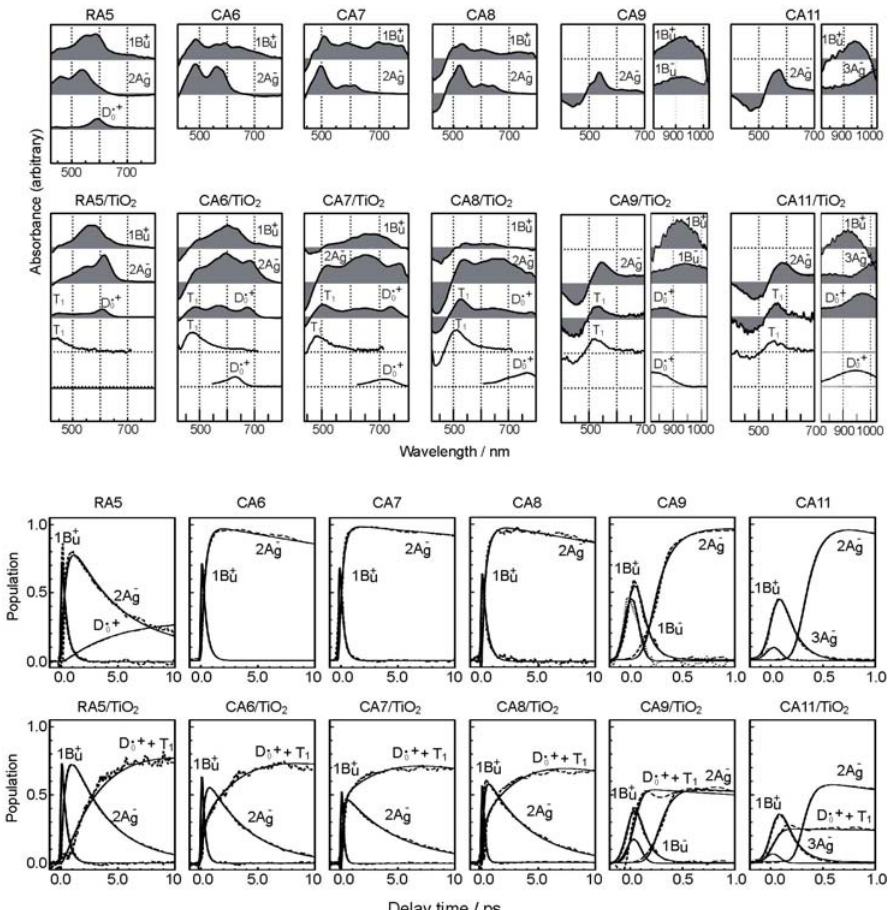
Figure 8. SADS and time-dependent changes in population for the RA and CA sensitizers free in ethanol solution (the first and the third panels) and bound to TiO suspension (the second and the fourth panels) (reprinted with permission from [11] © 2005, American Chemical